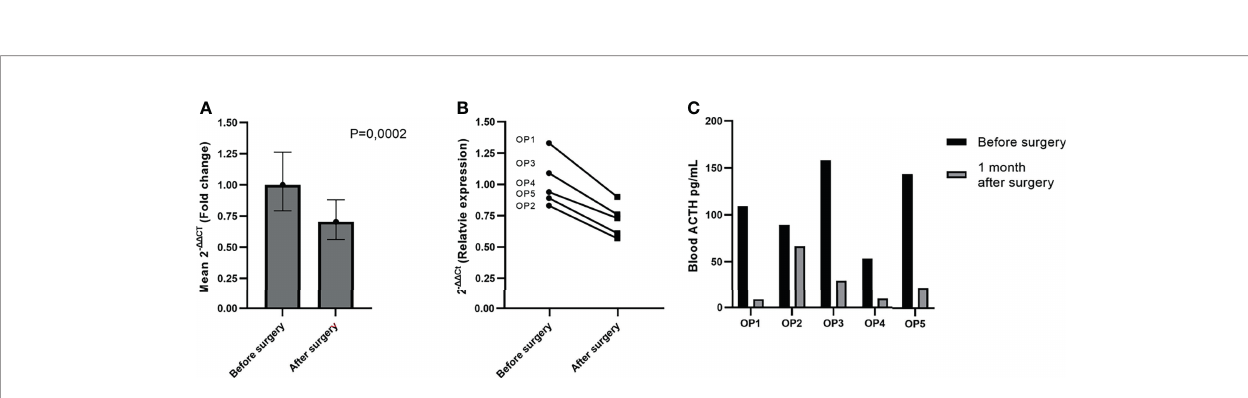
FIGURE 6 | Reduction of miR-7-5p in plasma 24 hours after surgery. (A) Graph represents the expression values were calculated with DD Ct method and are represented as fold change. In our sample set of fi ve patients miR-7-5p was slightly downregulated in plasma 24 hours after surgery (P = 0.0002). (B) Graph represents the relative expression of miR-7-5p before and after surgery in each patient individually. The P value was calculated using paired t-test. (C) Graph represents ACTH measurements taken shortly before and one month after the PitNET surgery.